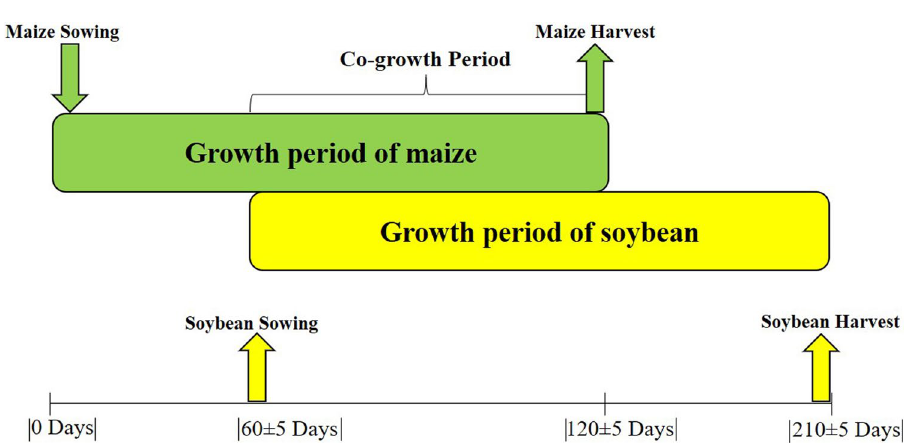
Figure 3. Illustration of the growth period of maize soybean relay intercropping system (MSR). The upper- bar represents the growing period of the maize crop (120 ± 5 days, first sown relay-crop), and the lower-bar shows the growing period of the soybean crop (150 ± 5 days, second sown relay-crop). The co-growth period (60 ± 5 days) is defined as the proportion of the total system growth period (210 ± 5 Days) that both relay-crops grow